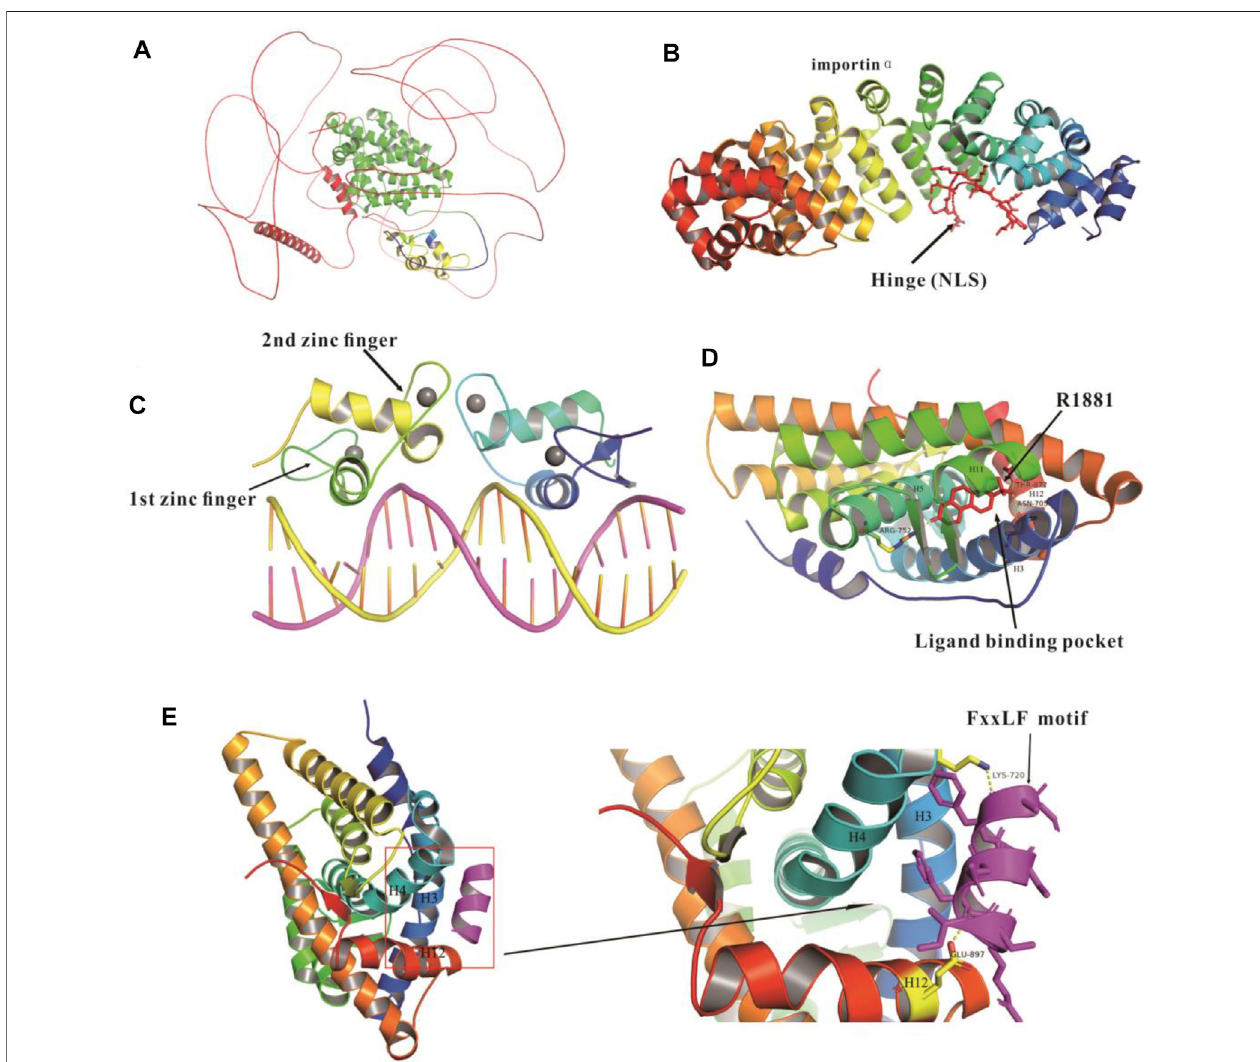
FIGURE 3 | Crystal structures of full length, and domains of DBD, hinge and LBD of AR protein. (A) Crystal structure of full-length AR (Uniport: P10275, AlphaFold2).NTD,(aminoacidresidue1-555)(red),DNAbindingdomain(DBD,aminoacidresidue556-620)(yellow),hingedomain(aminoacidresidue617-668)(blue); hingeand ligandbindingdomain (hinge-LBD,Aminoacidresidues 617-918)(green);LBD(amino acidresidues 669-919)and ARNLSregions(aminoacidresidues617- 635) (color gradient). (B) Crystal structure of hinge domain and NLS regions (amino acid 621-635) (red) complexed with importin- α (PDB: 3BTR). (C) Crystal structure of DBD (PDB: 1R4I). (D) Crystallographic structure of protein complex containing LBD and a synthetic androgen metrexone R1881 (PDB: 1E3G), the ligand bindingpocketsurrounded bytheN-terminusofH3,H5,H11andH12. (E) Structure ofARLBD complexwithFxxLFmotifpeptide (purple),the fi gure ontheright shows the interface between AR LBD and FxxLF motif (PDB:1T7R). Hydrogen bonds are shown in dotted yellow